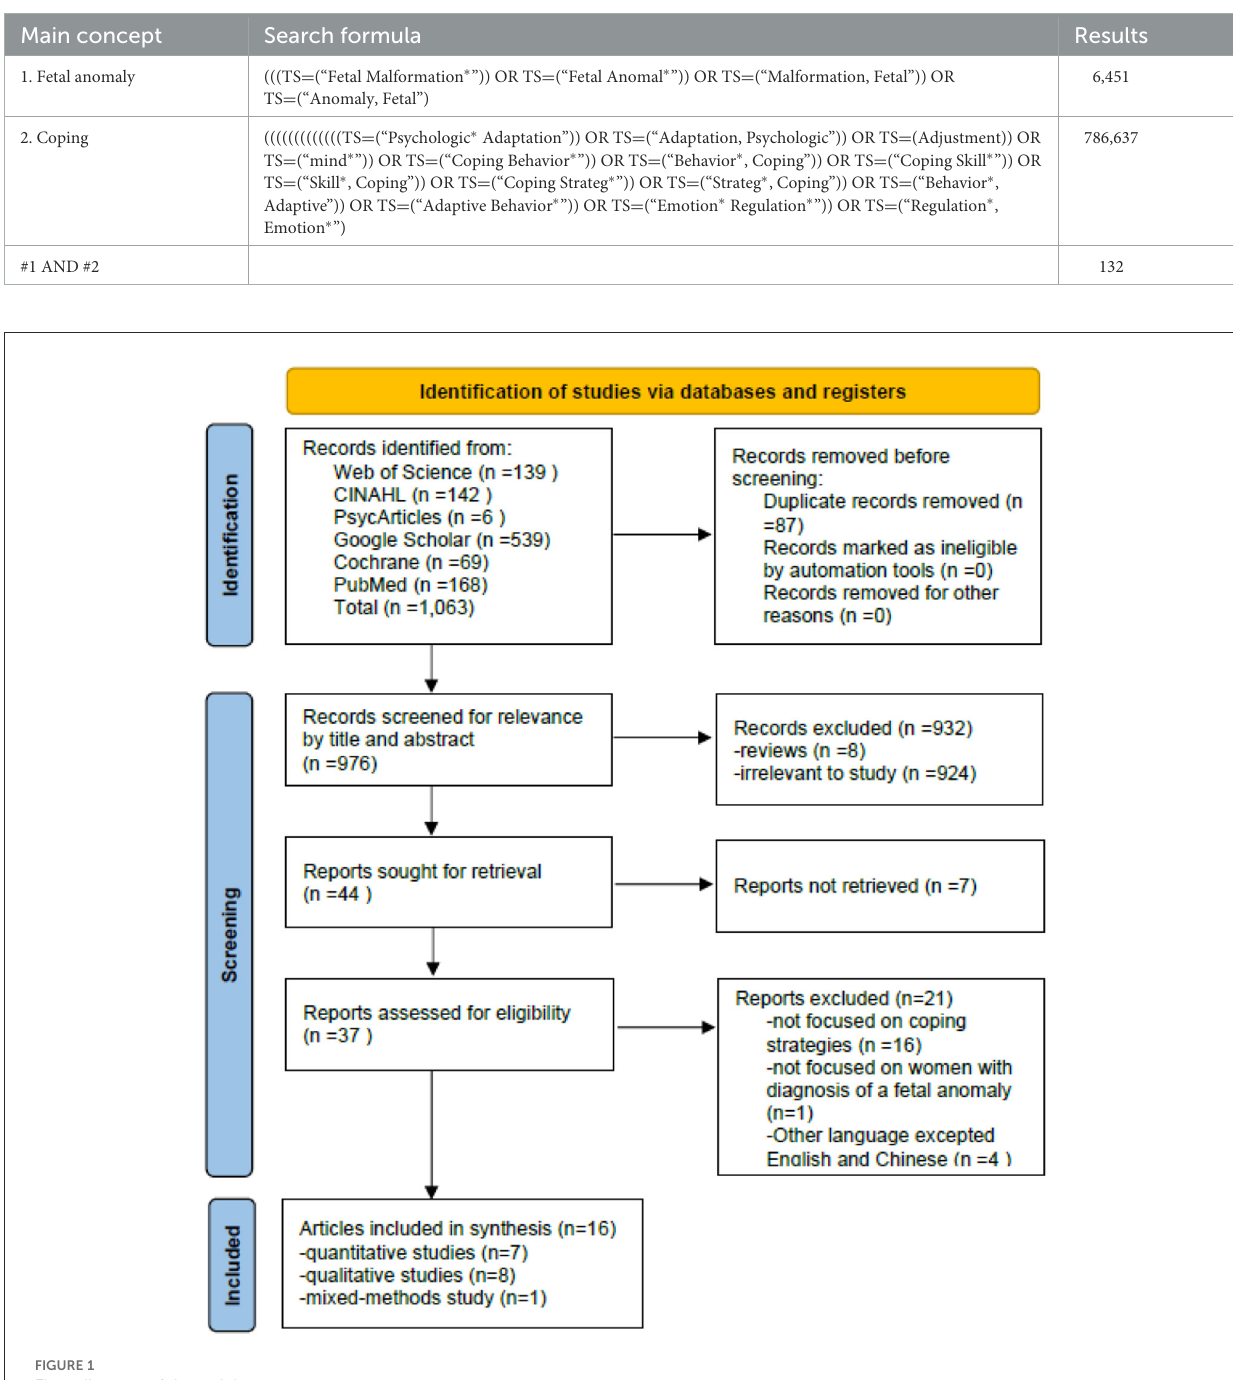
FIGURE1 Flow diagram of the